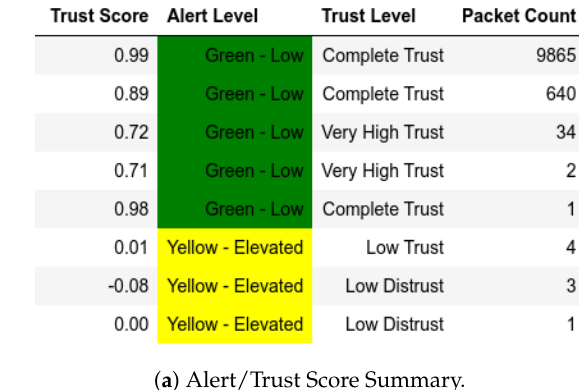
Figure 34. Client: ATENA H2020 dataset internal test- H s in MitM capture.